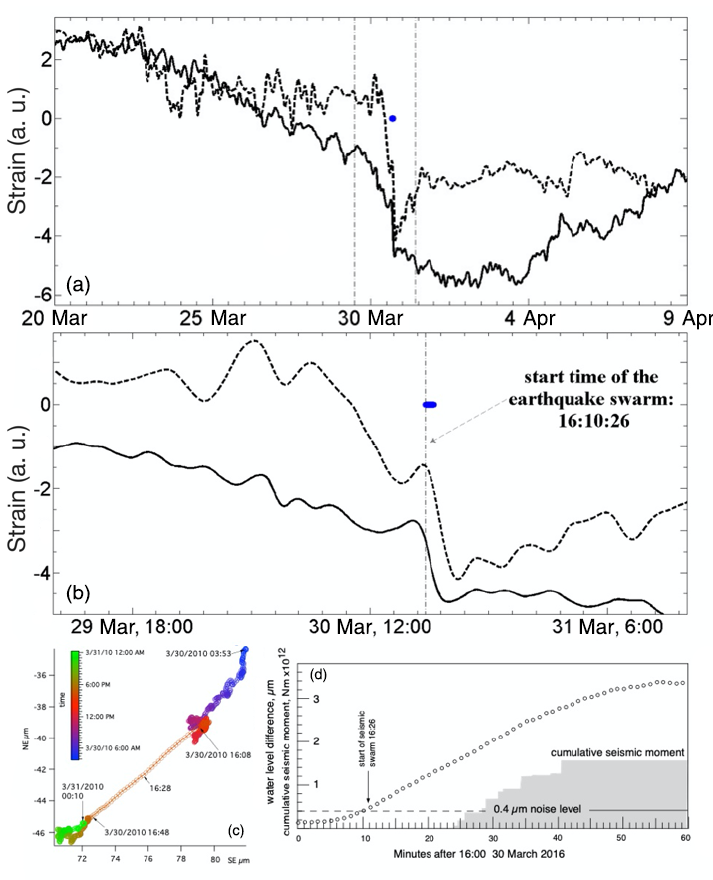
Figure 9. (a) and (b) show strain (RT, continuous line) and southward tilt (dashed line) preceding and accompanying the Astroni-Pisciarelli seismic swarm in March 2010. The tilt amplitude unit is µrad and the strain unit multiplier is 10 − 8 . (b) shows an expanded view of the deformation, and (c) and (d) shows the tilt vector at one-minute intervals, compared to the seismic moment release, the bulk of which occurs 15–30min after the first microearthquake in the swarm. The dashed line lower right shows the 10–30min RMS noise-level threshold in the raw data. The first microearthquake corresponds to the approximate time at which the tilt signal exceeds the short term noise level, however, the microseismic energy release starts 15min after this threshold is exceeded, suggesting its utility in early warning methods.